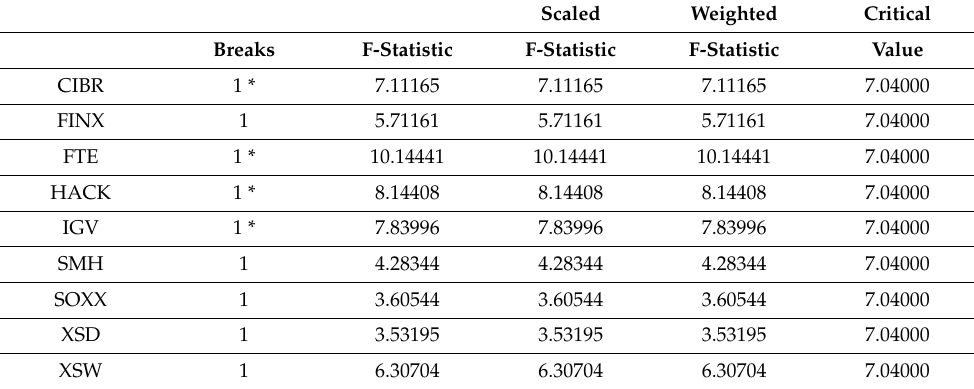
Table A5. Multiple breakpoint Bai–Perron tests for ETF excess return.